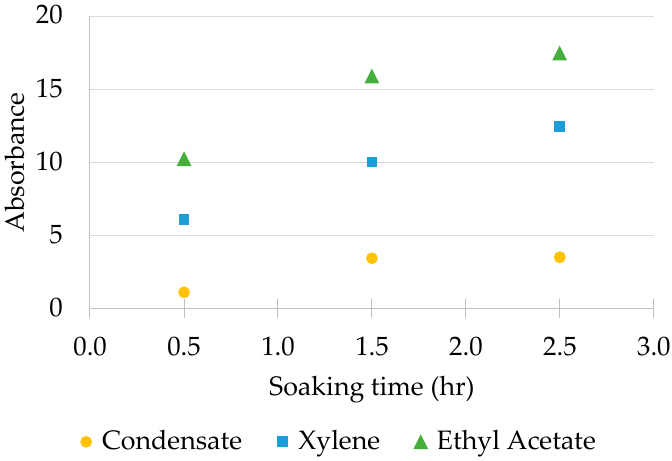
Figure 4. UV-VIS absorbance of soak solvent against wax soaking time.